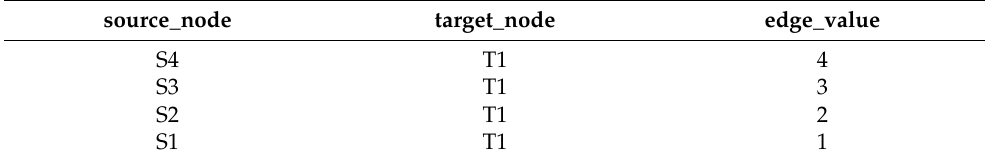
Figure 2. The three input data examples explained in Section 2.1.3, evolving from least to most complex. Table 1. The simplest of the three data examples described in Section 2.1.3. These data are visualized in Figure 2a.